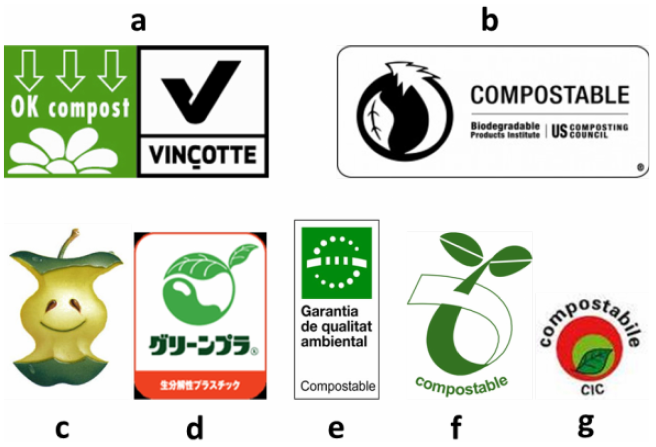
Figure 2. Selection of logos which indicate the biodegradability of products, e.g., as used in Belgium ( a ), North America ( b ), Finland ( c ), Japan ( d ), Catalonia ( e ), Germany ( f ), and Italy ( g